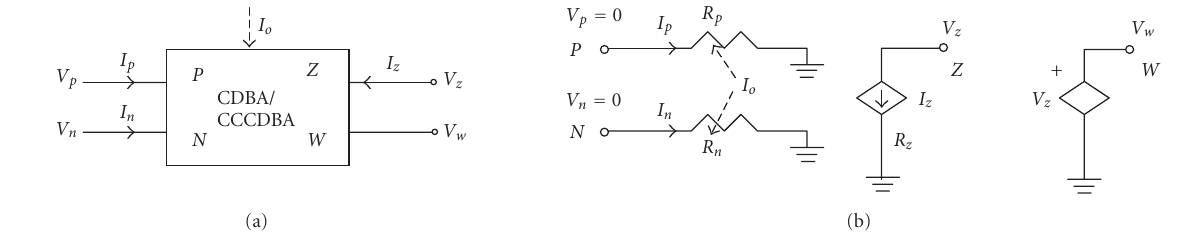
Figure 1: (a) CDBA/CCCDBA symbol and (b) equivalent circuit of CDBA/CCCDBA.